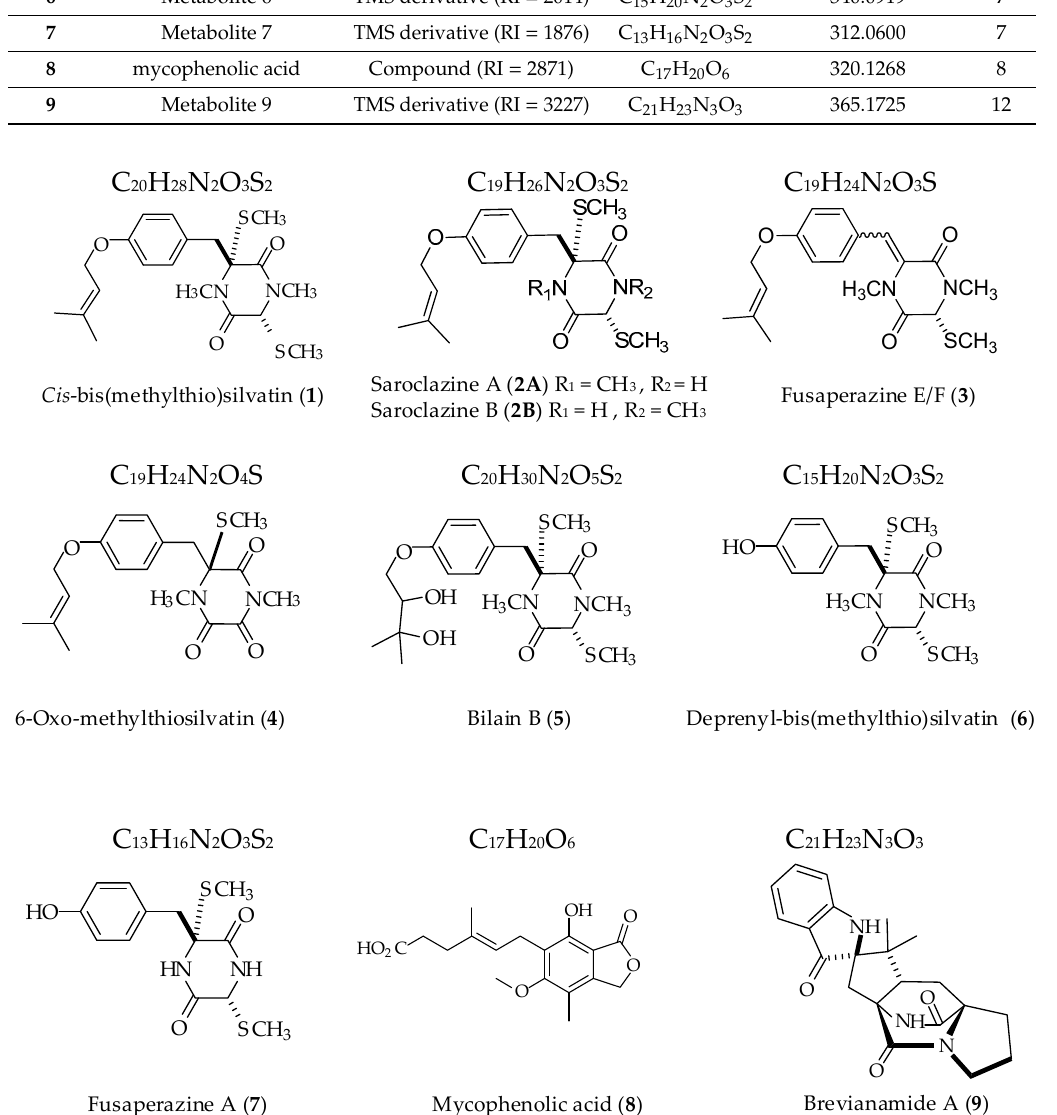
Figure 1. Structures of target secondary metabolites ( 1 – 9 ) identified in the organic extract of strain Figure 1 . Structures of target secondary metabolites ( 1 - 9 ) identified in the organic extract of strain AN4. It is to be specified that, unlike cis -bis(methylthio)silvatin ( 1 ), whose configuration was assigned by NMR, the determination of stereochemistry was not possible for compounds identified via MS.